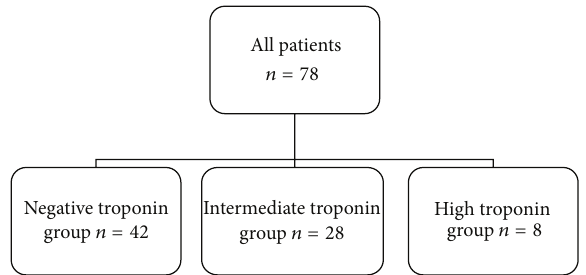
Figure 1: Stratification of patients within the